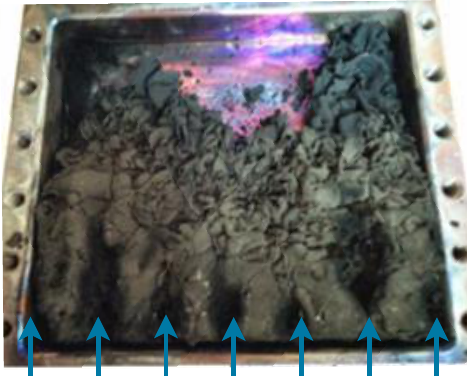
Figure 4. Carbon nanofiber growth inside a mold. The arrows represent the inlet channels where reactive gases entered the chamber but hinder the fiber growth.